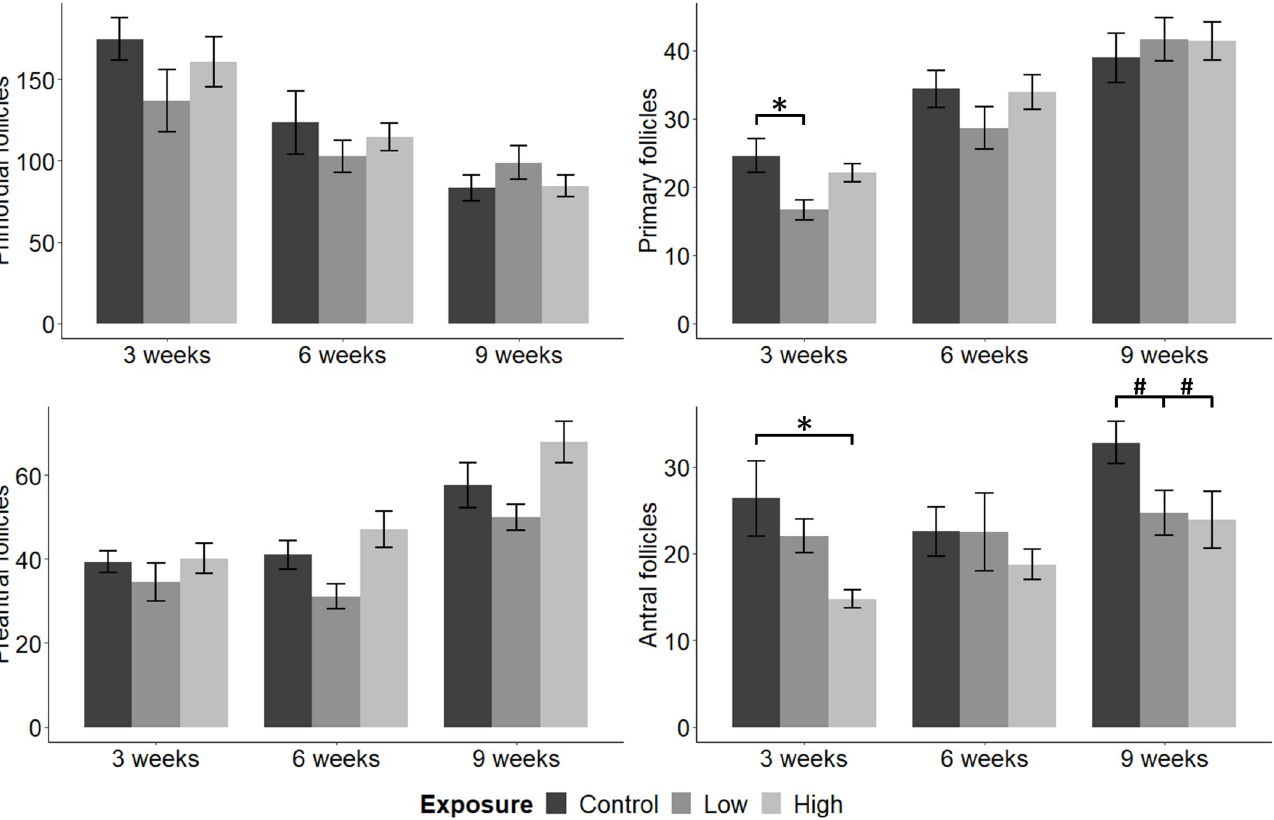
Fig 2. Ovarian follicle numbers. The number of primordial, primary, preantral and antral follicles in ovaries of 3, 6 and 9-week-old female offspring maternally exposed to a mixture of POPs at Control, Low or High doses (0x, 5000x or 100 000x human estimated daily intake, respectively). Histopathological examination was conducted on every 10th ovarian section. Results are presented as mean ± standard error. 3 weeks: n = 9, 11 and 12 for Control, Low and High, respectively. 6 weeks: n = 11, 10, and 11 for Control, Low and High, respectively. 9 weeks: n = 10, 11 and 9 for Control, Low and High, respectively. � p-values � 0.05. #p- values �